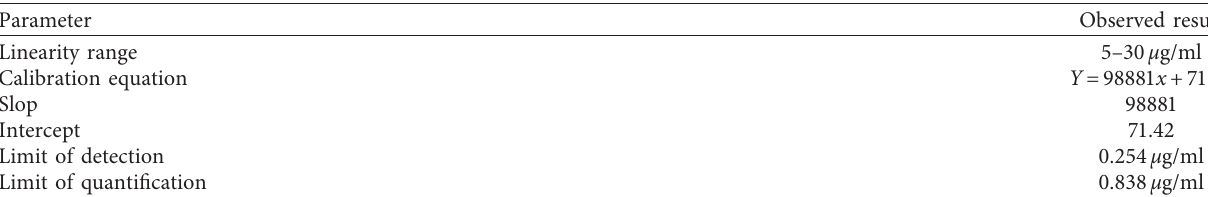
Table 4: Linearity data of ATS.